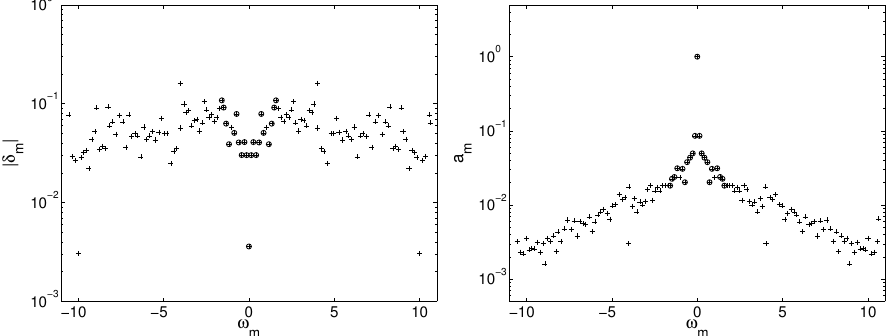
Figure 14. Counterpart of Figure 5 the three-blades turbine applying HODMD in 145 snapshots starting at time 25.604